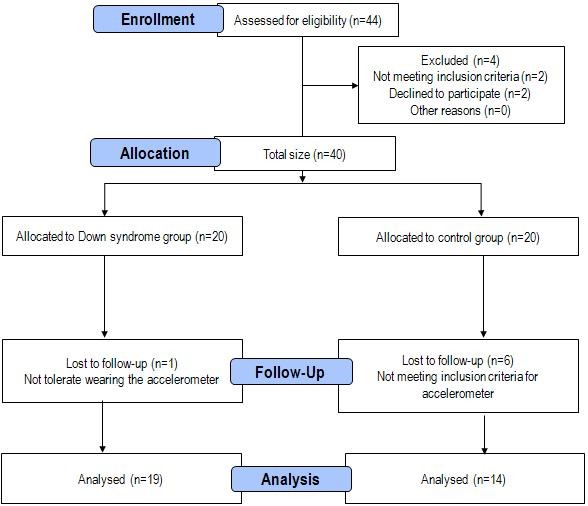
Consort flow diagram.